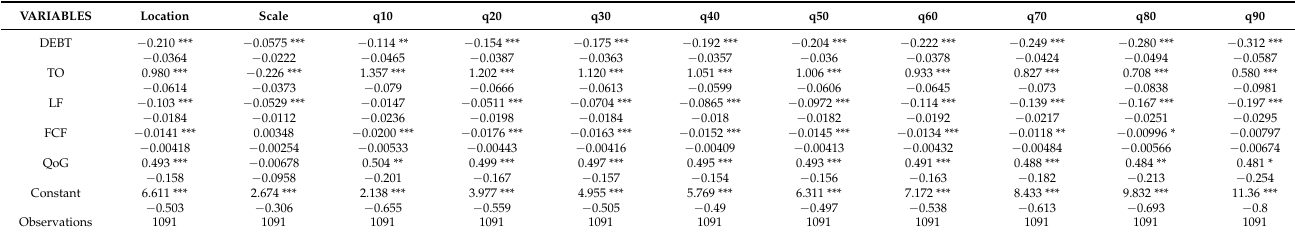
Table 4. Impact of governance on growth under different quantiles.